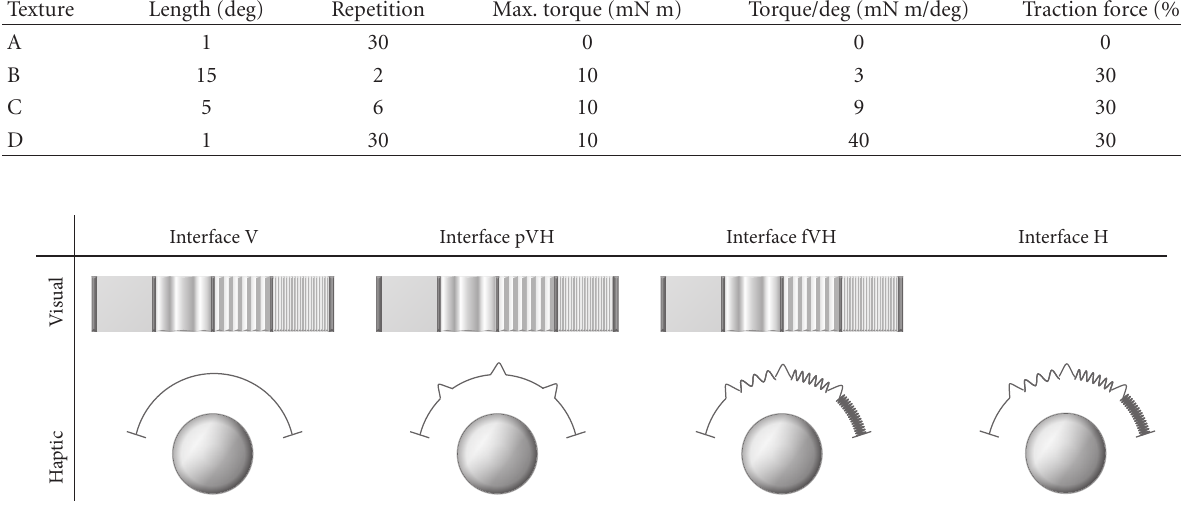
Figure 2: The visual and haptic information provided in the four di ff erent interfaces (V, pVH, fVH, and H). The haptic information is represented visually around the haptic rotary device. The visual and haptic textures are placed in alphabetic order (A, B, C, and